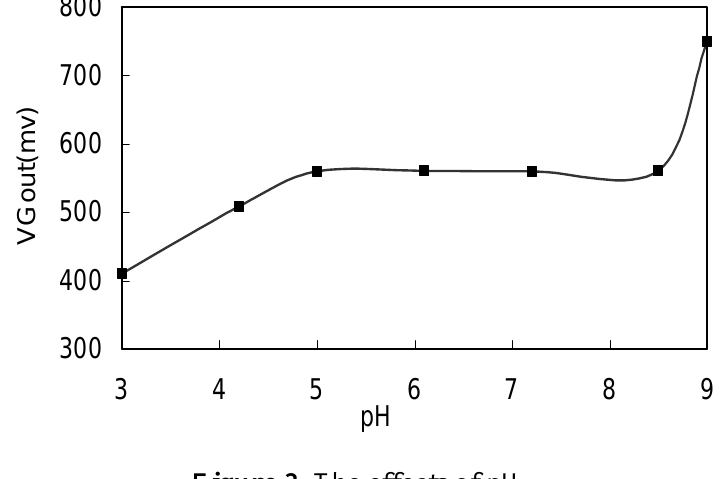
Figure 3. The effects of